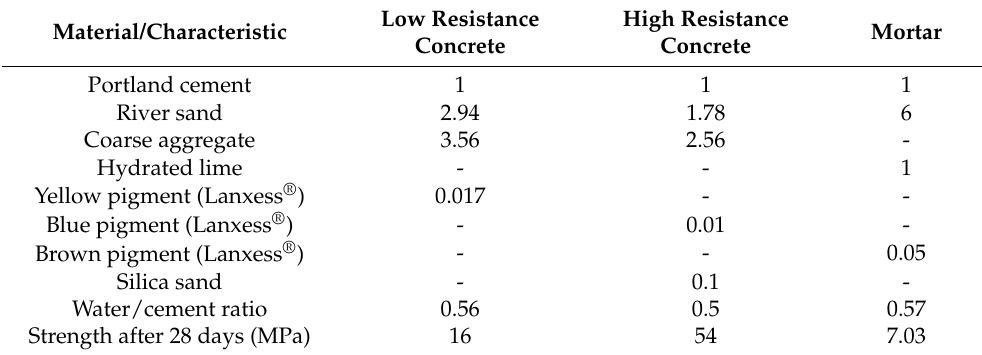
Table 1. Mix design and characteristics of mortar and concretes. Material/Characteristic